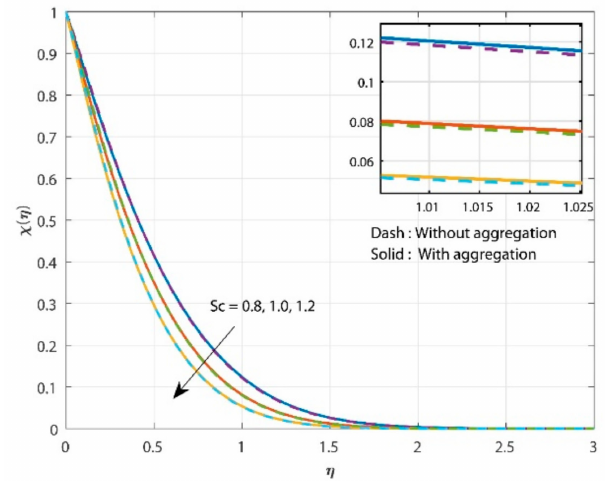
Figure 7. Influence of Schmidt number on χ .